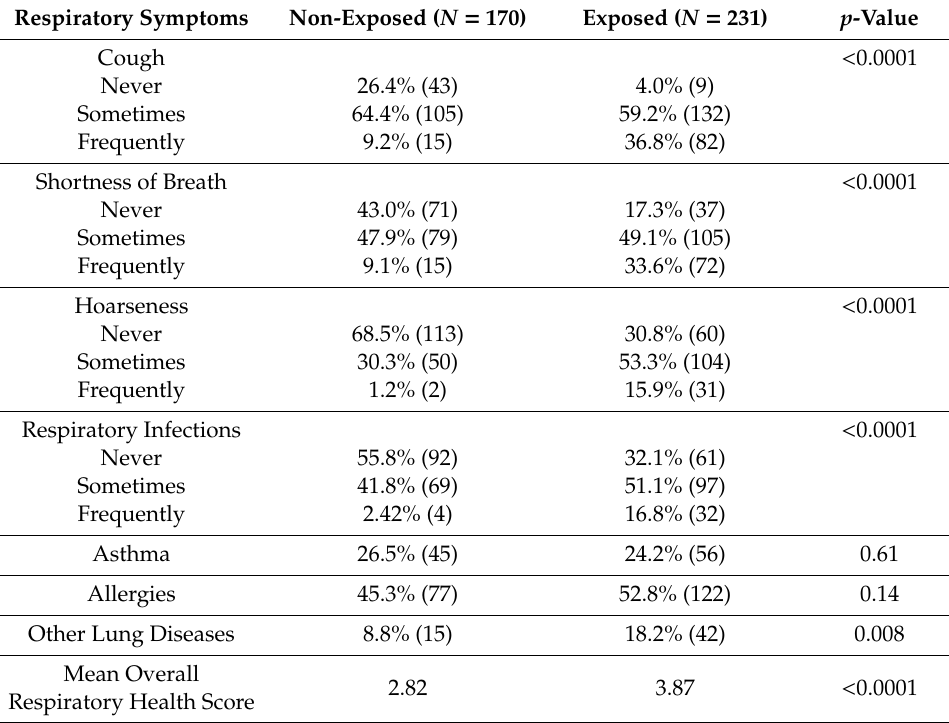
Table 2. Prevalence of reported respiratory symptoms.